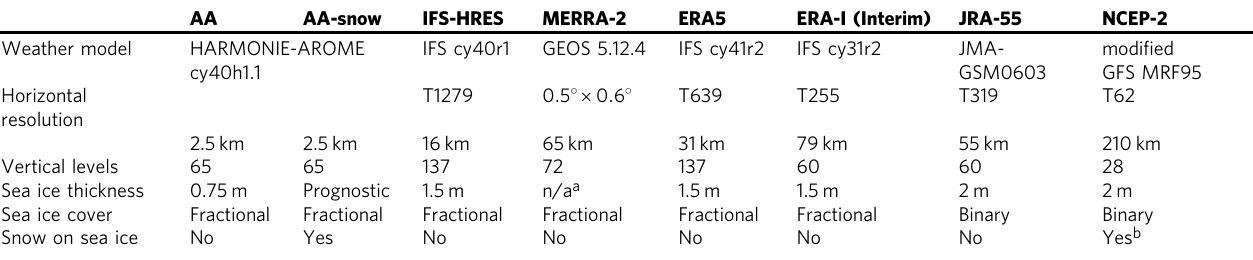
Table 1 Overview of the numerical weather prediction systems and global reanalysis systems